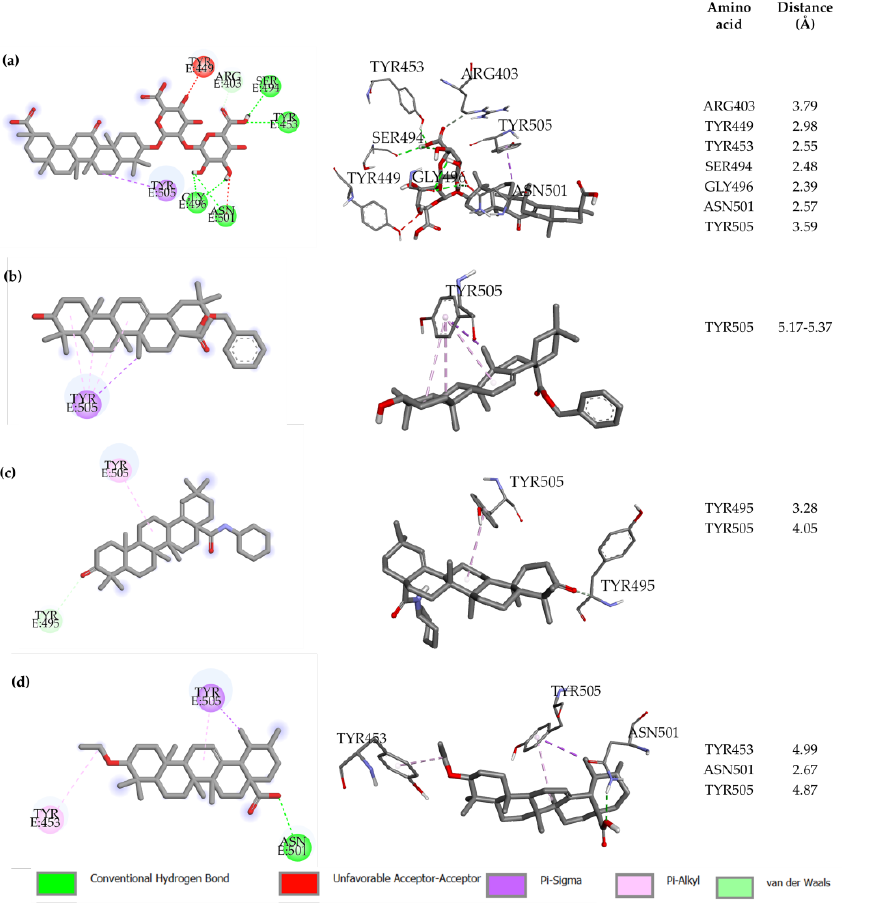
Figure 2. 2D (left) and 3D (right) interaction diagram for: ( a ) GA reference molecule, ( b ) OA5 , ( c ) MA4 and ( d ) UA2 derivatives. Residue – ligand distances are shown. All diagrams were constructed with Discovery studio 2021. Interaction-type color labels are displayed.